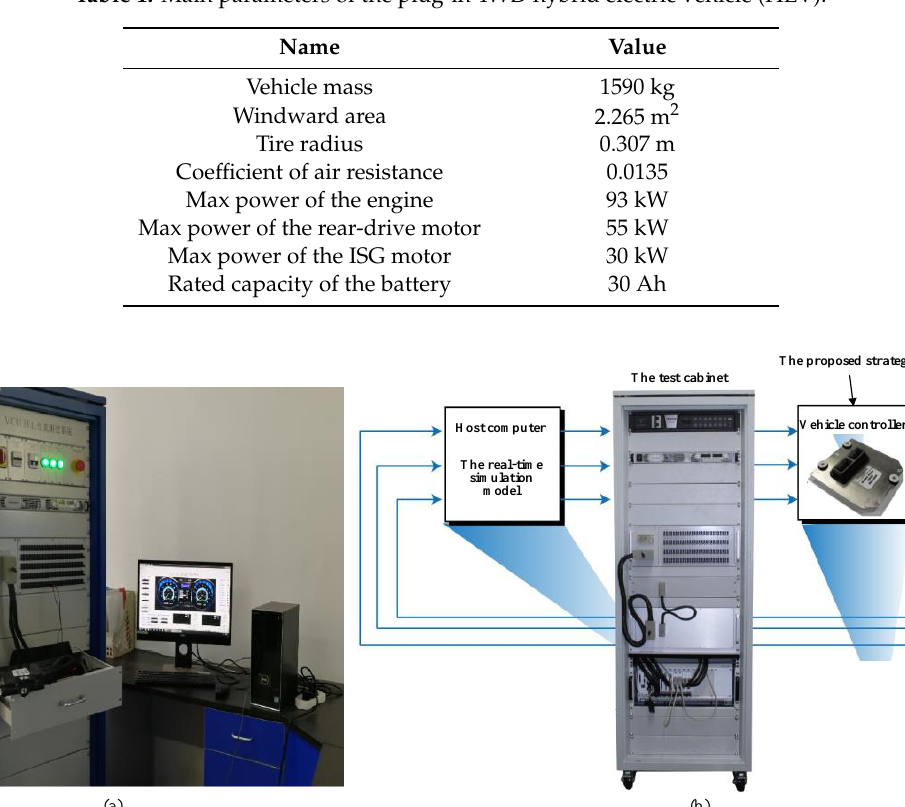
Figure 8. ( a ) The hardware-in-the-loop test system. ( b ) Schematic diagrams of the hardware-in-the-loop test system.